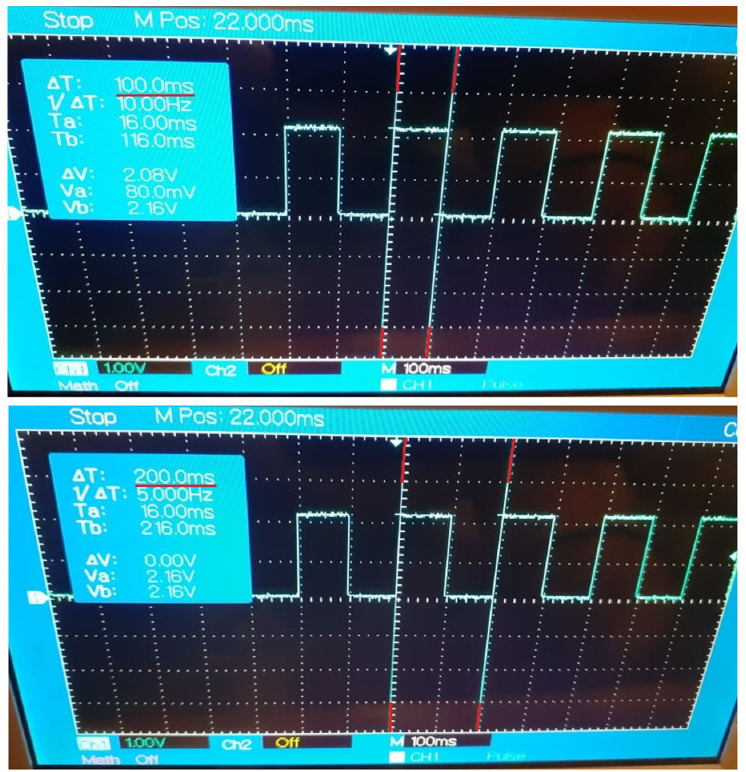
Figure 5. Generated Digital Signal based on payload delivered by the Gateway Application at 100 ms recurrence.